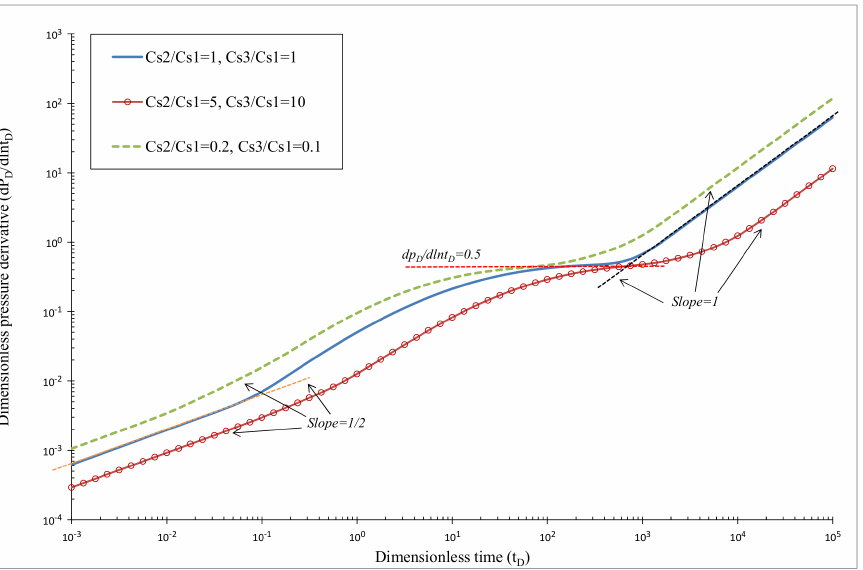
Figure 14. Dimensionless pressure derivative dp D / dln ( t D ) vs. dimensionless time t D under vari- ous storativity ratio among layers with 2